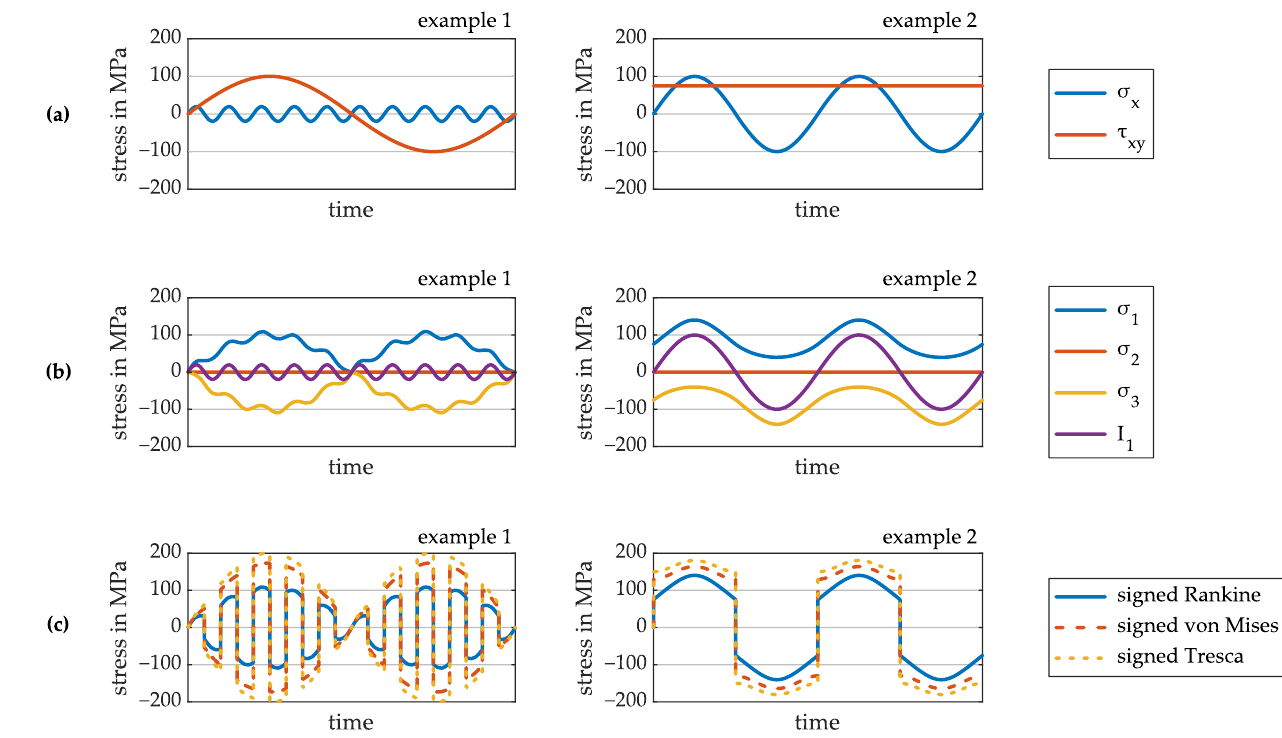
Figure 5. Two examples for combinations of normal and shear stresses that lead to ( a ) nonproportional loading and the resulting ( b ) principal stresses and first invariant and ( c ) signed equivalent stresses.